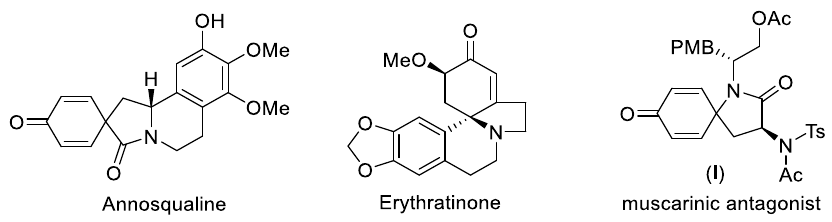
Figure 1. Representative azaspirocyclohexadienone-based bioactive